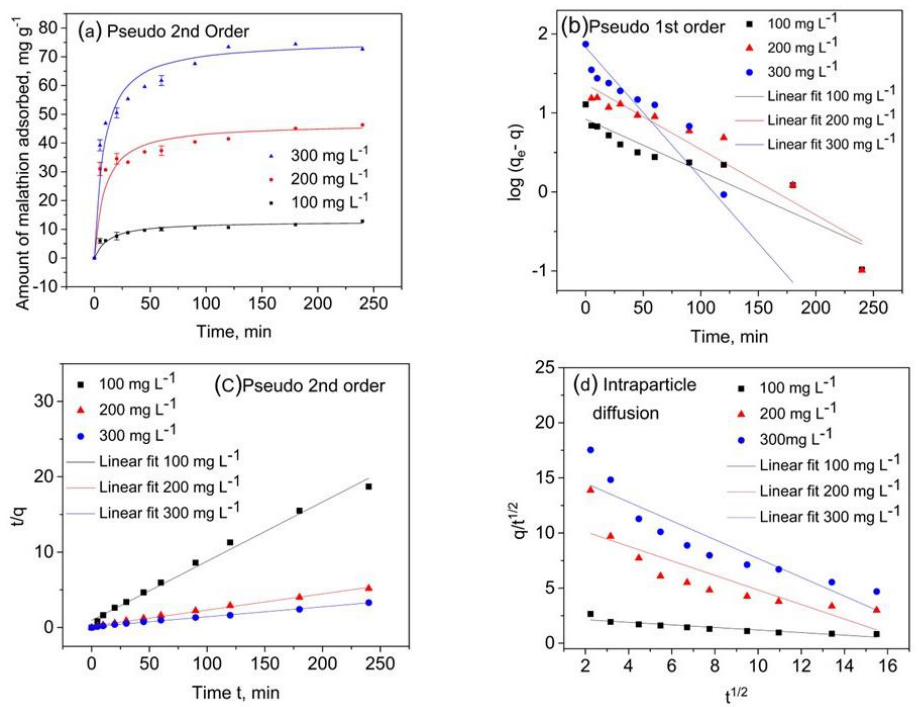
Figure 4. The kinetics of malathion adsorption onto SG-LGPS. Experimental: 0.1 g of SG-LGPS, 25 mL of malathion solutions, pH = 7, 298 K. ( a ) Symbols represent experimental data; solid lines are fittings of pseudo-second-order model; ( b ) Lagergren´s pseudo-first-order fittings; ( c ) pseudo-second-order fittings; ( d ) the intraparticle diffusion model.